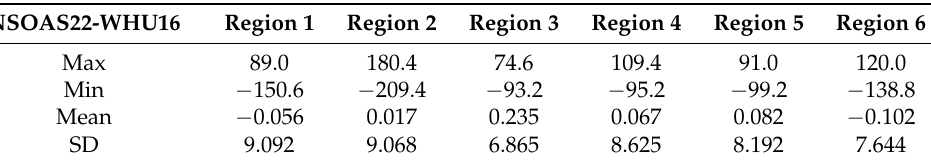
Table 8. Statistics of the differences between NSOAS22 and WHU16 in the six study regions (unit: mGal): Region 1, North Pacific; Region 2, South Pacific; Region 3, Mid-Pacific; Region 4, Indian Ocean; Region 5, North Atlantic; Region 6, South Atlantic.